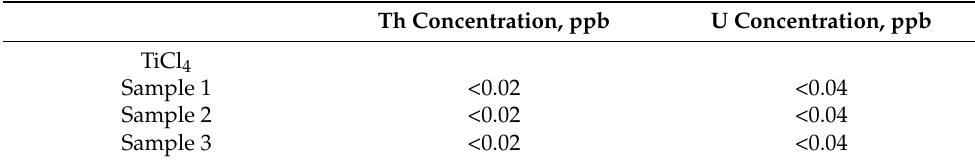
Table 1. The ICP-MS results of titanium tetrachloride (Component Reactiv LTD, Russia). Th Concentration, ppb U Concentration,